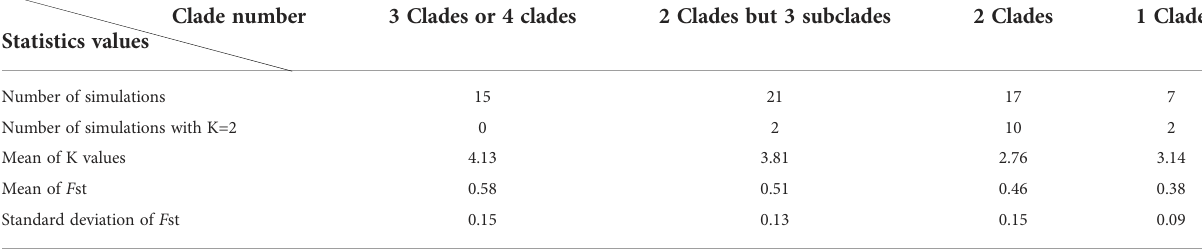
TABLE 1 Statistics of K values and F st of 60 simulations with 4 random populations and different clades or subclades using STRUCTURE and the delta K ( D K) methods. Clade number Statistics